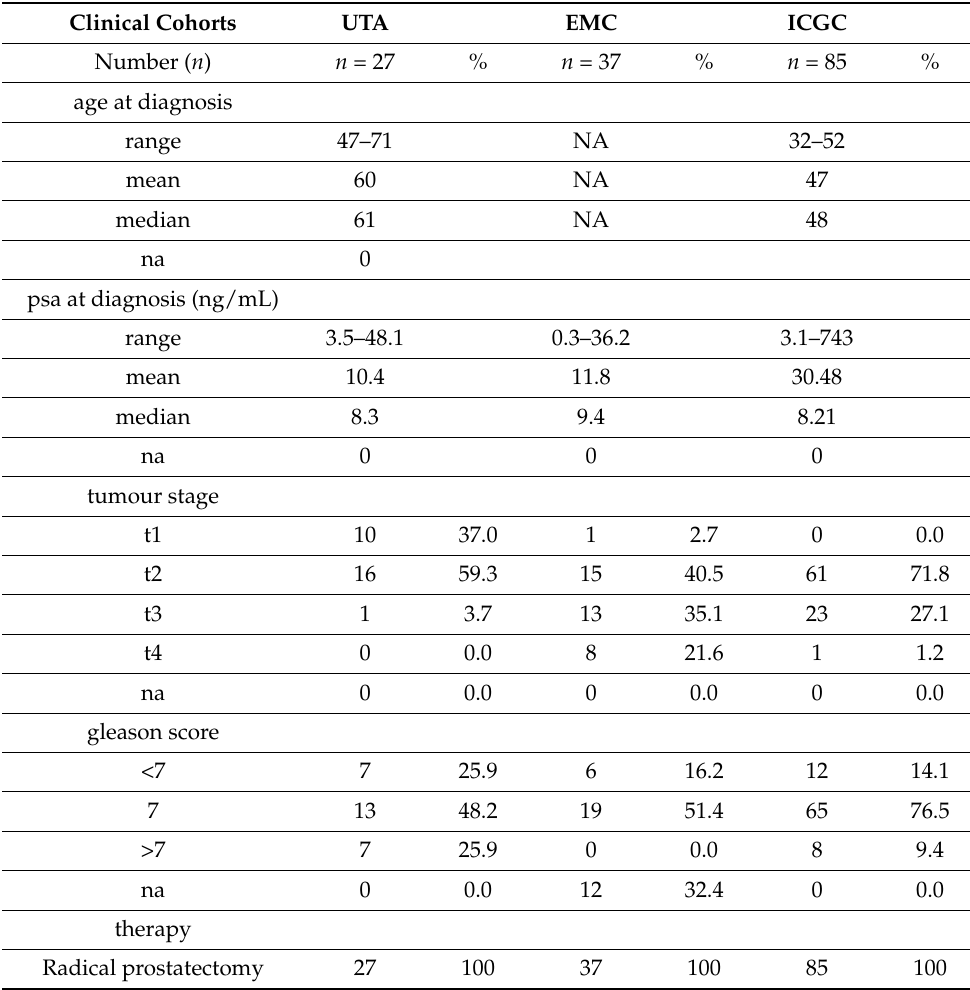
Table 1. Clinicopathological characteristics of patient cohorts (NA, data not